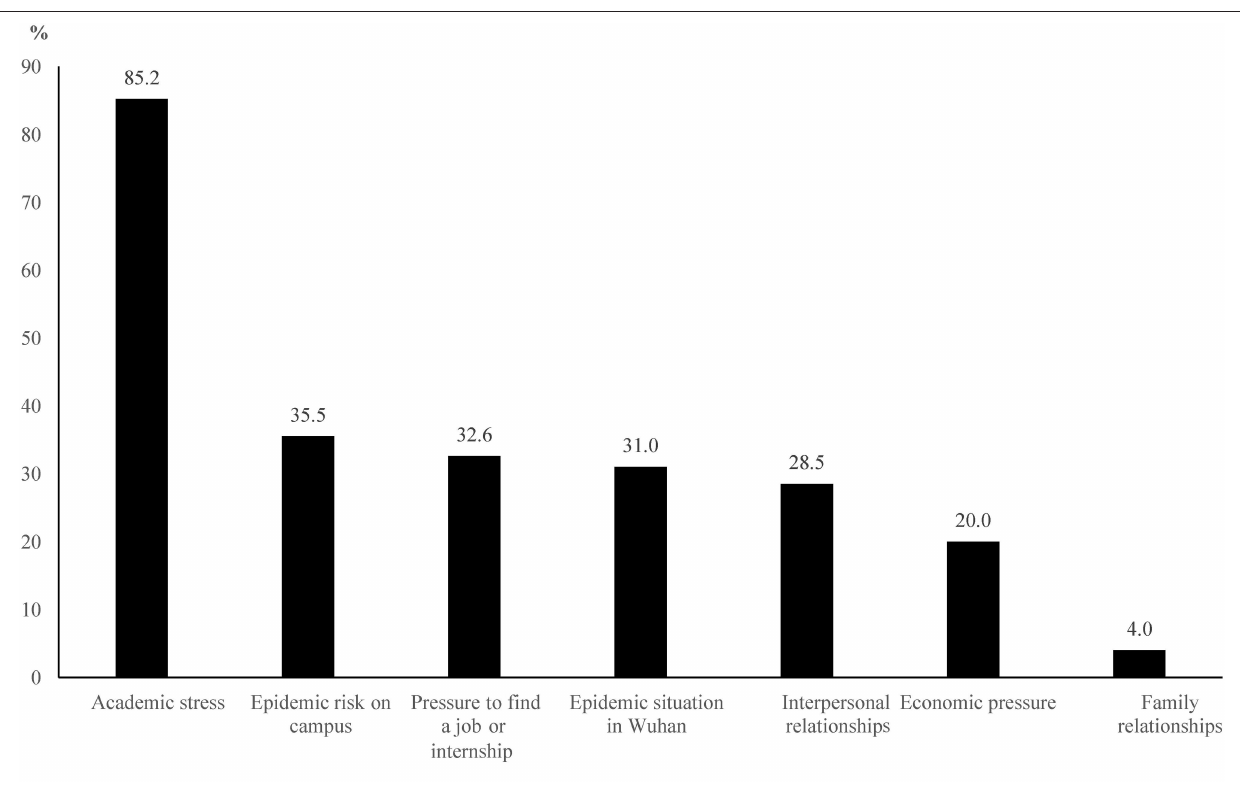
followed by the epidemic risk on campus (35.5%), pressure to Wuhan